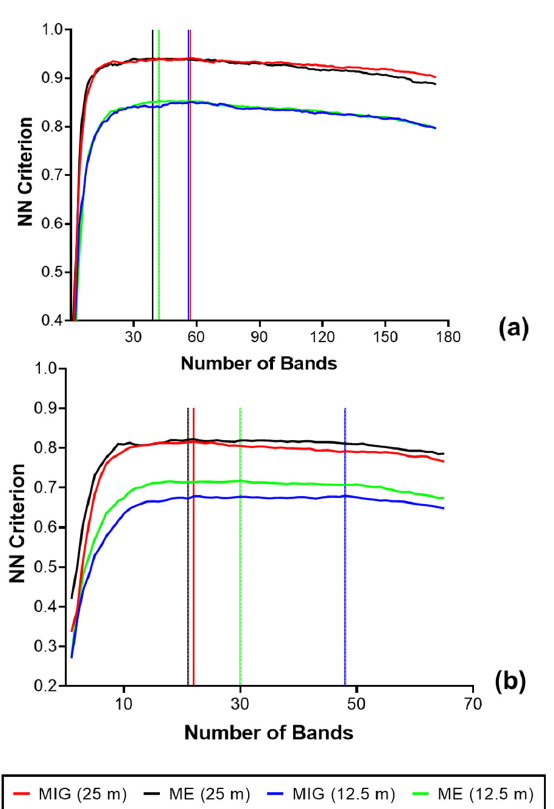
Figure 12. Results of the forward feature selection to determine the separability and optimal bands necessary for discriminating the six predominant species using SCM at the coarsest scale (62.5 m): ( a ) MIG–VNIR ( b ) MIG–SWIR, ( c ) ME–VNIR and ( d ) ME–SWIR.